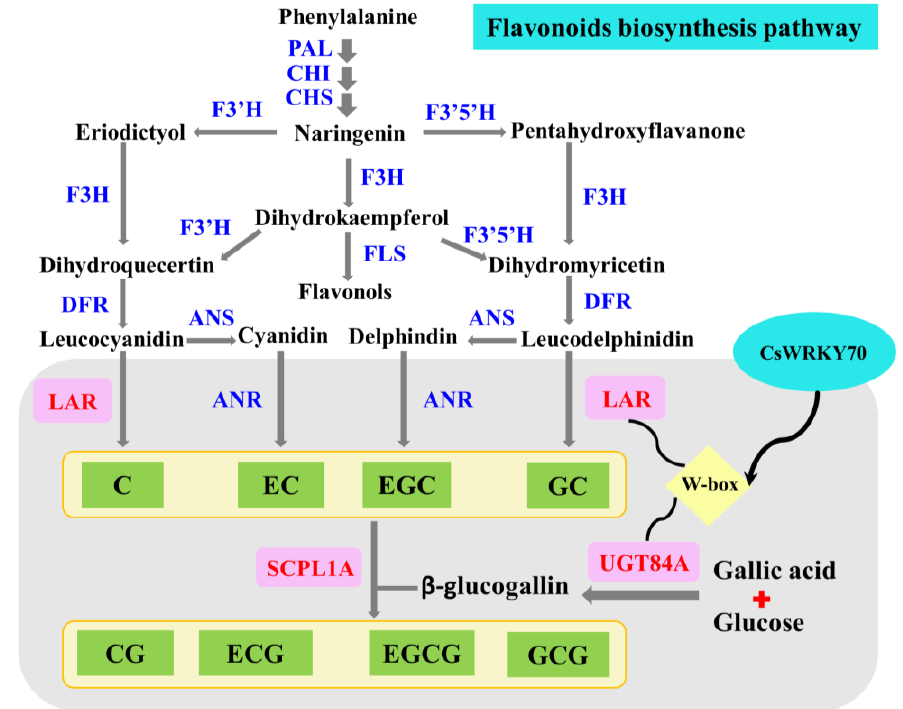
Figure 7. Diagram depicting the mechanism of CsWRKY70 affecting EGCG biosynthesis by regulating CsANR and CsSCPL1A expressions in tea leaves after nano-Se foliar application. PAL, phenylalanine ammonia lyase; CHI, chalcone isomerase; CHS, chalcone synthase; F3 ′ H, flavanone 3-hydroxylase; F 3′5′ H, flavonoid 3′ , 5′ -hydroxylase; F3H, flavanone-3-hydroxylase; FLS, flavonol synthase; DFR, dihydroflavonol 4-reductase; ANS, anthocyanidin synthase; ANR, anthocyanidin reductase; LAR, leucoanthocyanidin reductase; SCPL1A, serine carboxypeptidase-like acyltransferase; UGT84A, uridine diphosphate glucuronosyltransferase; C, catechin; EC, epicatechin; EGC, epigallocatechin; GC, gallocatechin; CG, catechin gallate; ECG, epicatechin gallate; EGCG, epigallocatechin gallate; GCG, gallocatechin gallate.